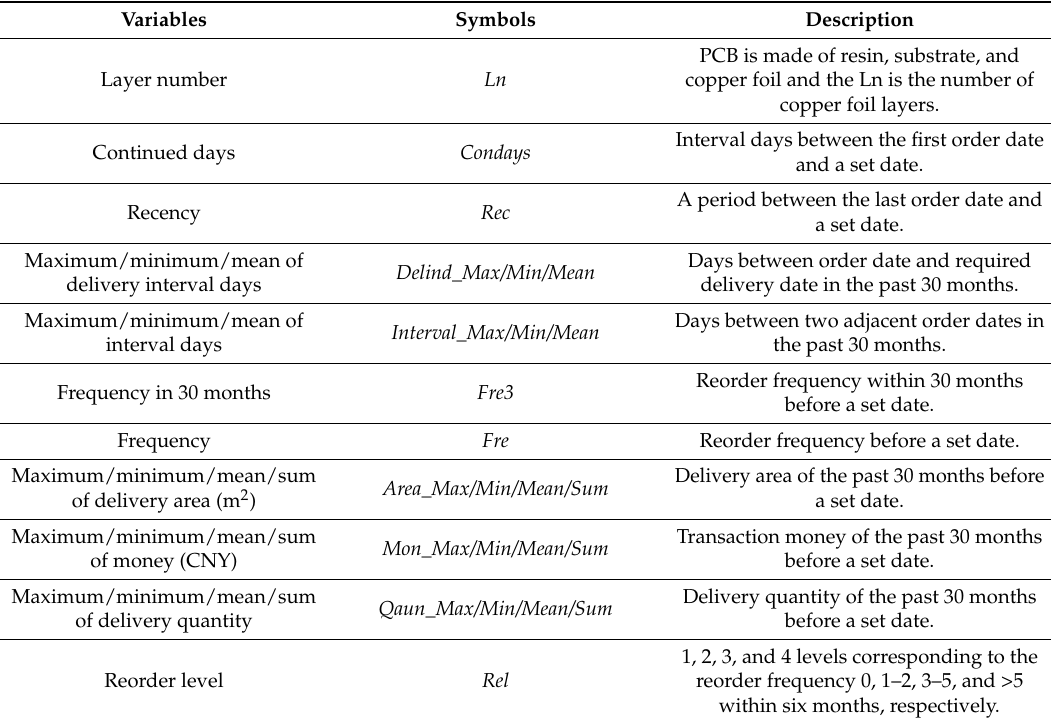
Table 1. Variable